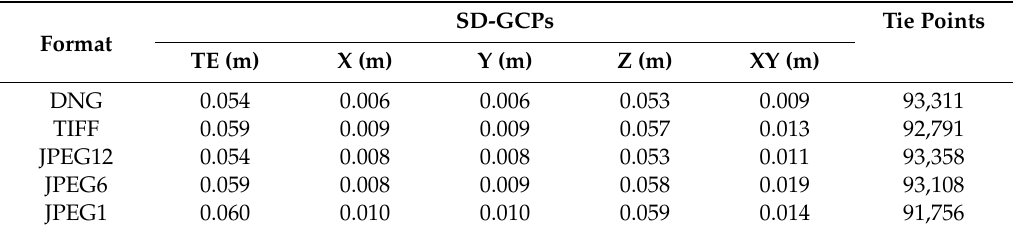
Table 3. Evaluation of the accuracy on GCPs and number of tie points—Test site 1.